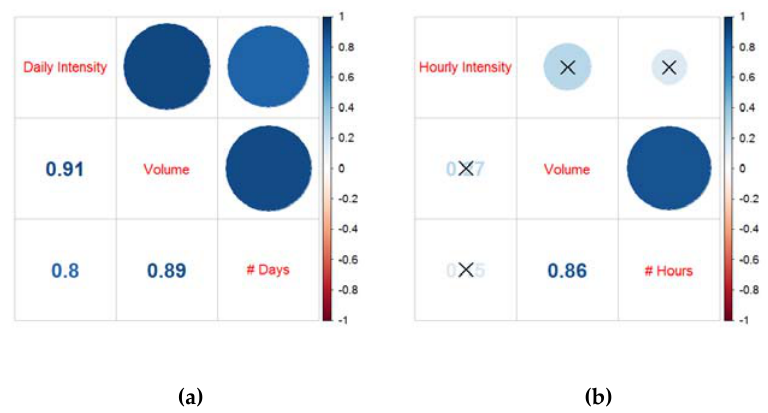
Figure 11. Matrixes show Kendall correlation relationships between average precipitation intensity, volume, frequency for daily ( a ); and hourly ( b ) data for Station 04. The color bar represents the Kendall tau value, and non-significant correlations at the 5 % significance level are designated with “×”.